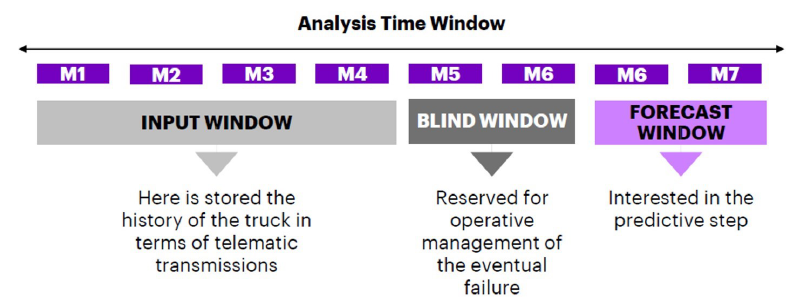
Figure 3. Time windows